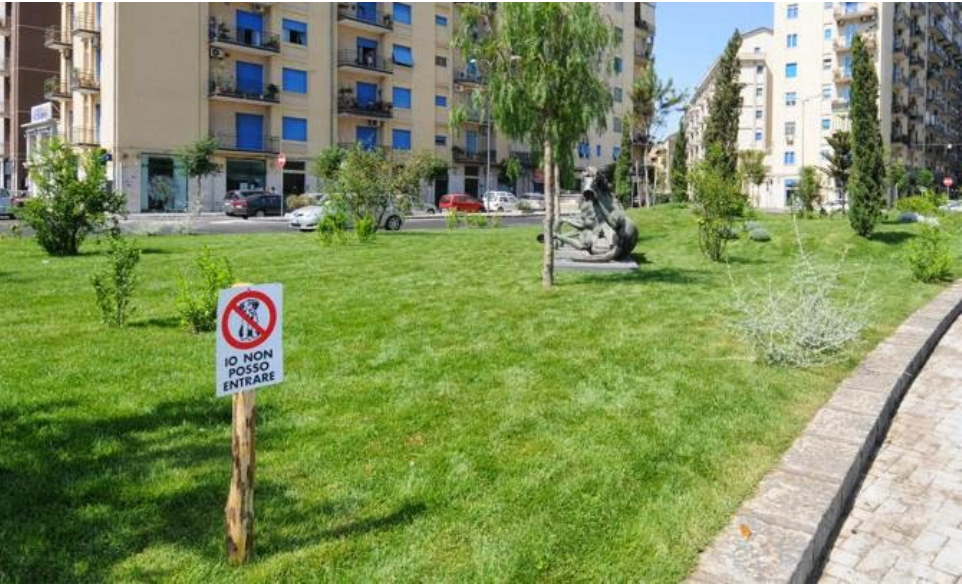
Figure 9. Piazza Galatea—Catania (today).